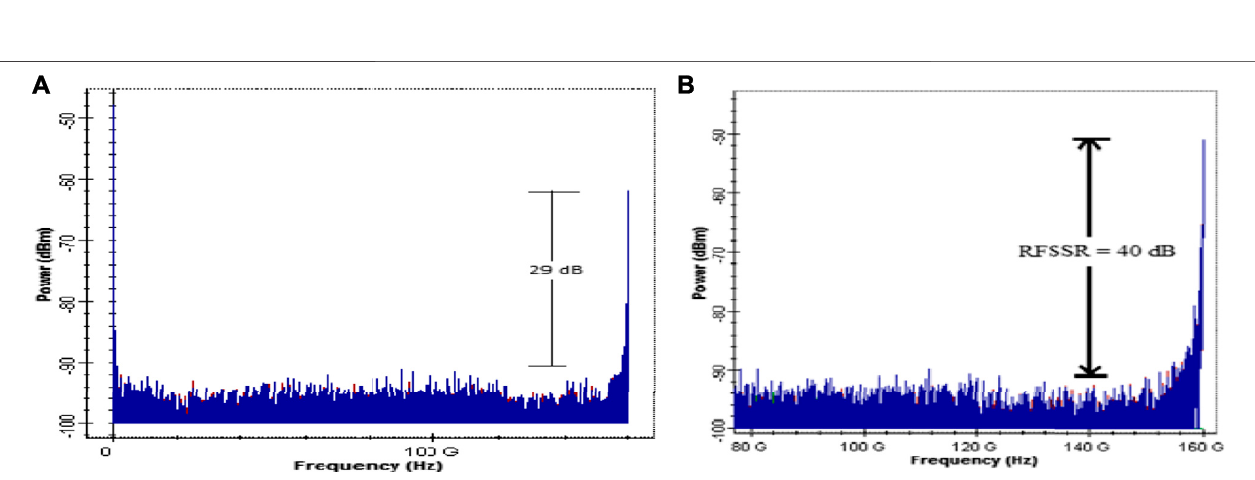
FIGURE 12 | RSSR for the system with (A) a single ampli fi er and (B) a cascaded ampli fi er.